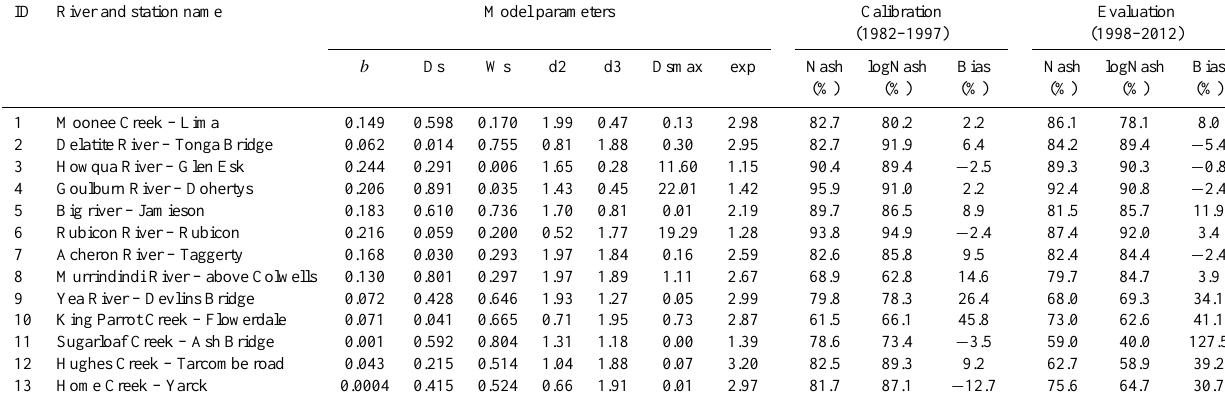
Table 1. Calibrated model parameters and model performance during calibration (1982–1997) and evaluation (1998–2012) periods.